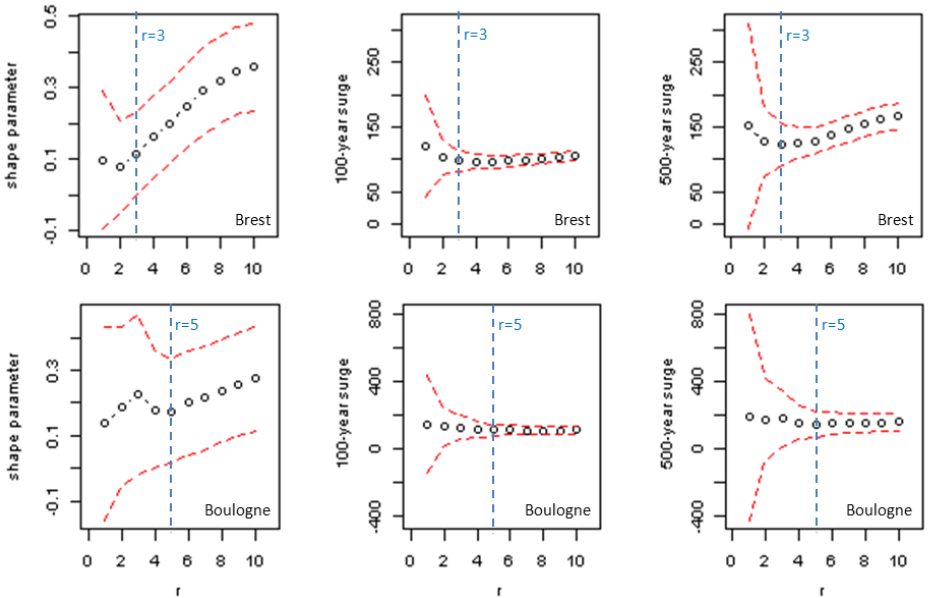
Figure 2. Estimation of r (the r -largest observations): the GEV shape parameter and 100 and 500-year storm surges (cm) with 95% confi- dence intervals (Brest and Boulogne